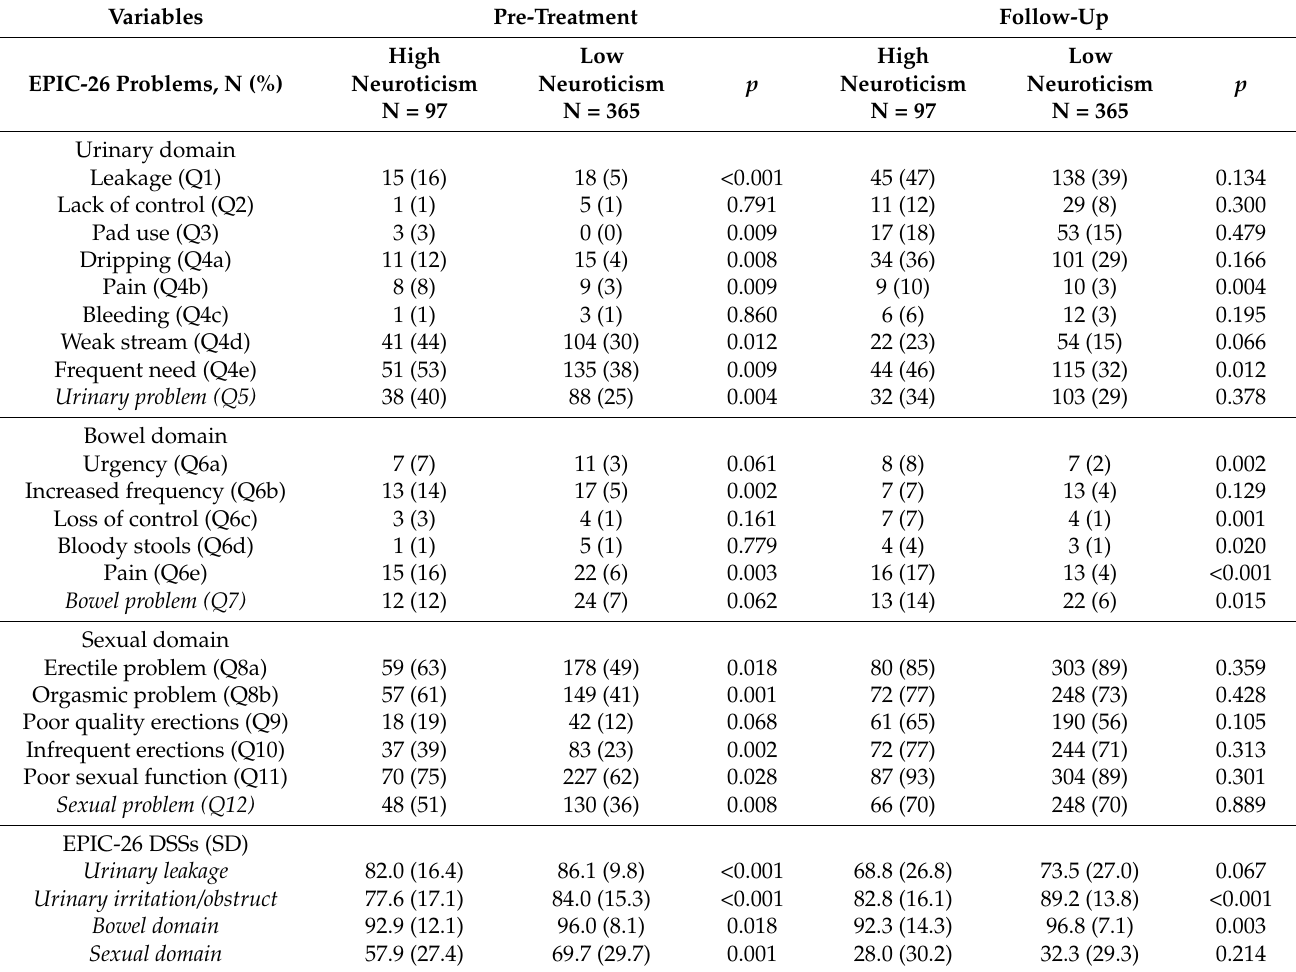
Table 2. EPIC-26 rates of problems and DSSs of the high and low neuroticism groups at pre-treatment and follow-up (N =